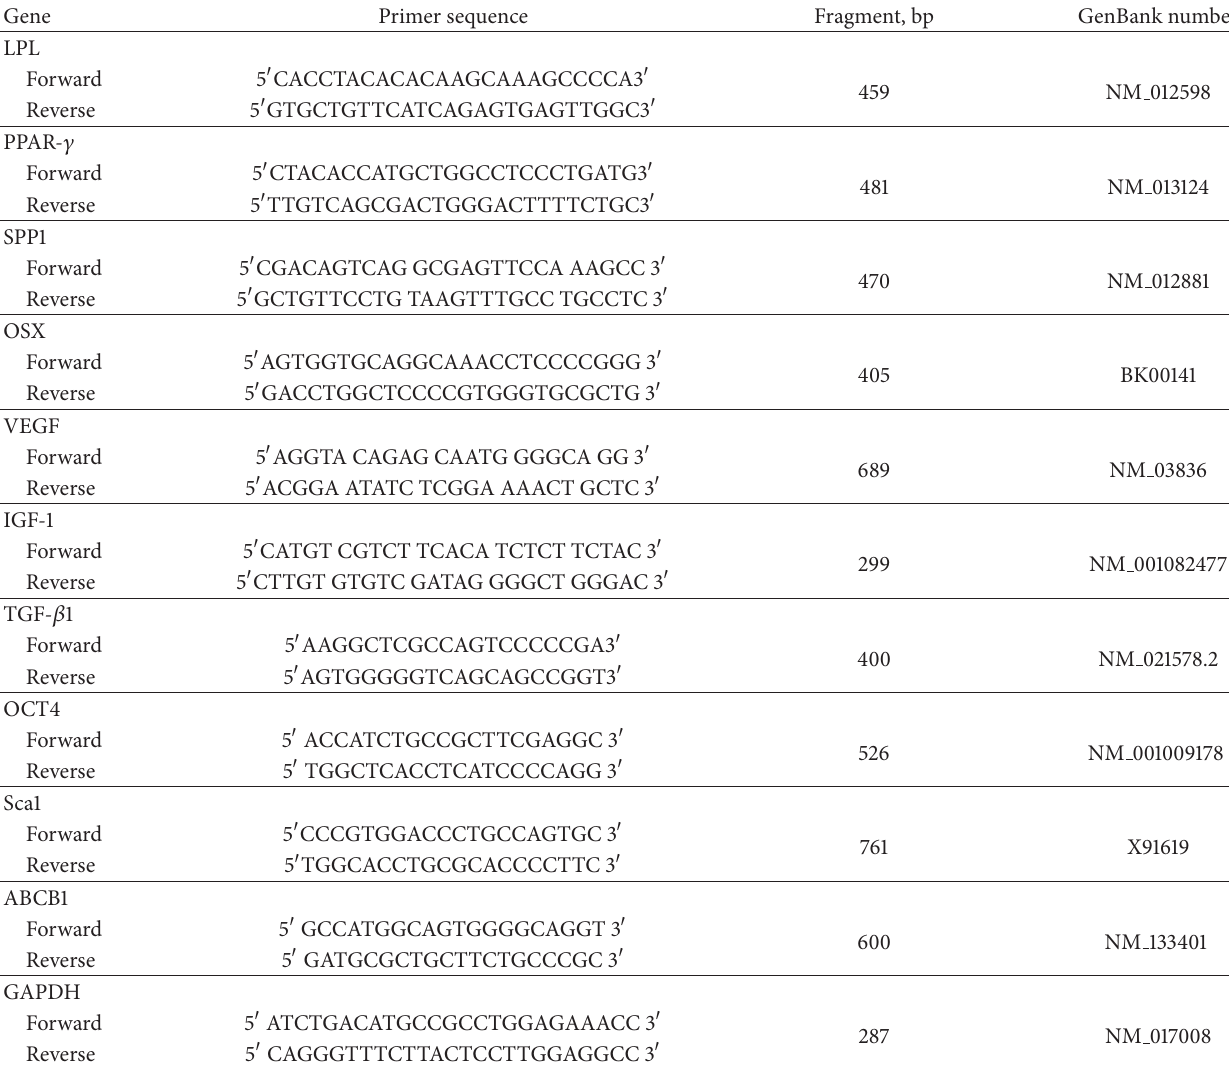
Table 1: Primers of specific markers for transdifferentiation, cytokines, and stem cell genetic